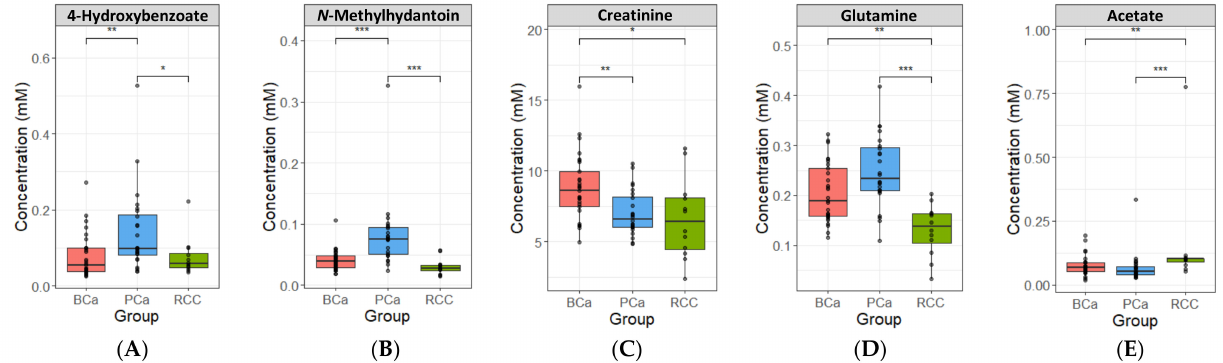
Figure 3. Boxplots of metabolites concentrations that were significantly different among BCa, PCa, and RCC from non- parametric analysis of covariance (Ranked ANCOVA). ( A ) 4-hydroxybenzoate (4-HBA), ( B ) N -methylhydantoin ( N -MH), ( C ) creatinine, ( D ) glutamine, and ( E ) acetate. Each dot in the boxes represents an individual sample concentration. * <0.05, ** <0.01, ***